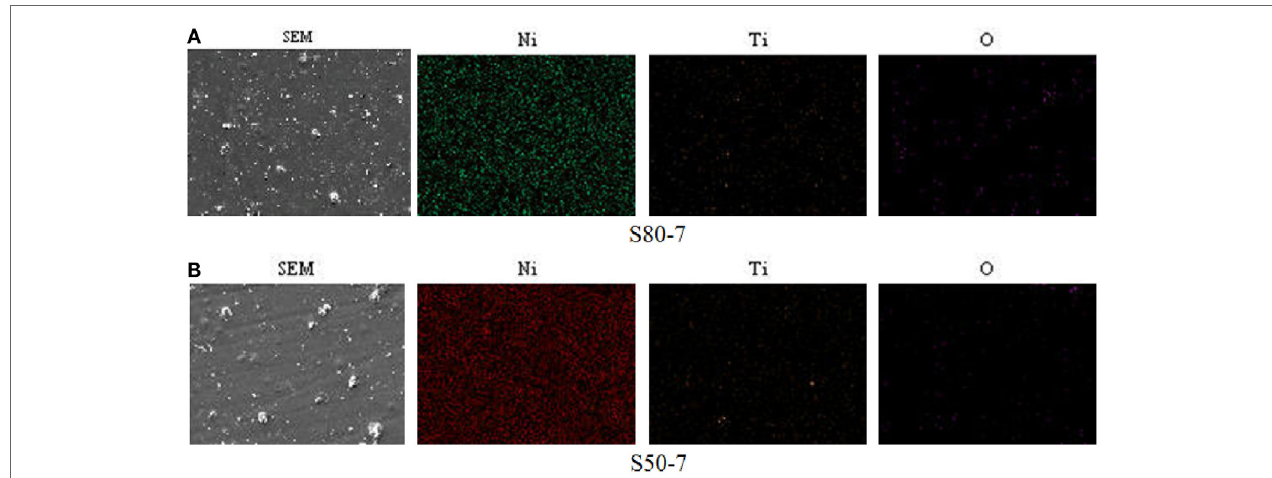
FigUre 3 | eDs mappings of ni, Ti, and O elements for the ni–TiO 2 nanocomposite coatings prepared at 7 a dm − 2 current density with 50 nm sized